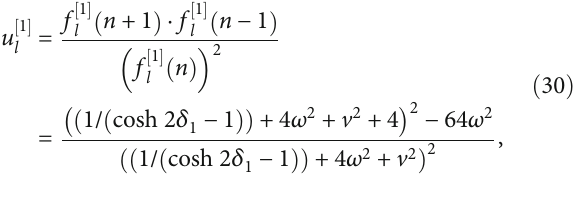
= 0 and β 0 = 0 . (c) Soliton molecule in β 0 1 2